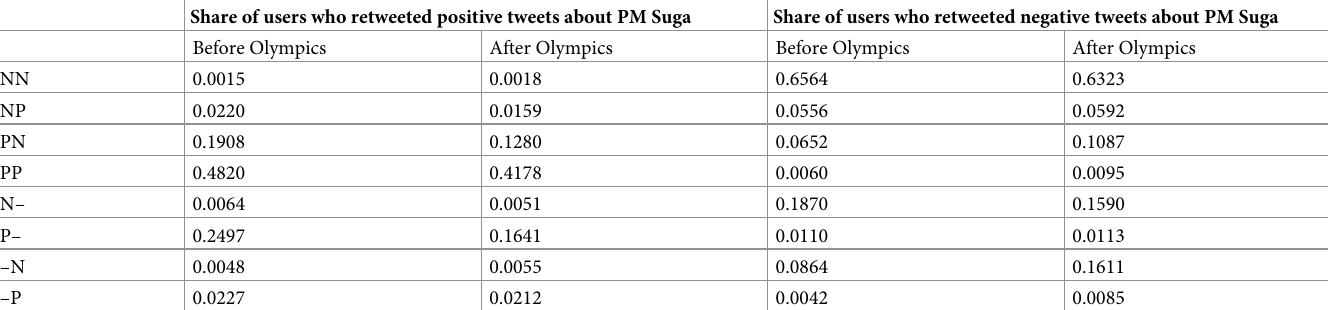
Table 4. Changes in attitudes toward the Olympic Games at the individual level.